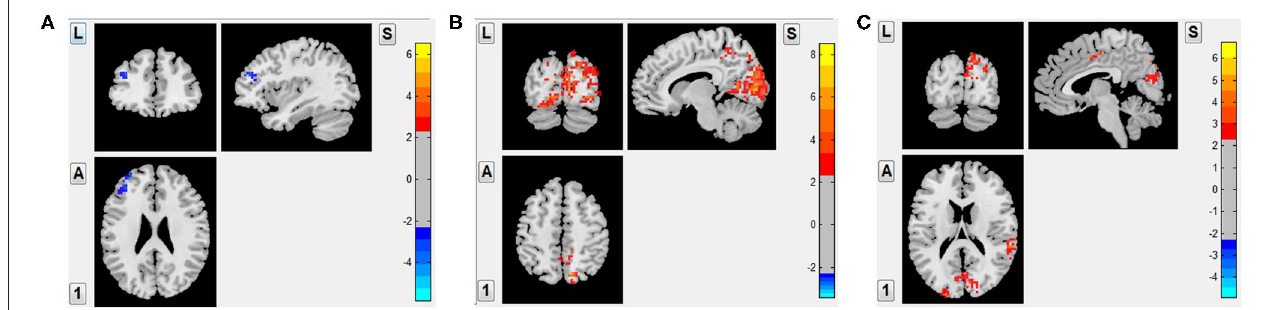
FIGURE 2 | The alteration whole brain functional connectivity of 11 patients with MCS after different tDCS protocols. (A) : 1-week sham tDCS vs. the baseline: decreased FC intensity in left middle frontal gyrus ( FDR corrected p < 0.001); (B) : 2-week real tDCS vs. the baseline: increased FC intensity in right precuneus and the bilateral occipital lobe ( FDR corrected p < 0.001); and (C) : 2-week real tDCS vs. 1-week sham-tDCS: bilateral supplementary motor area, right angular gyrus, and right superior temporal gyrus ( FDR corrected p < 0.001).